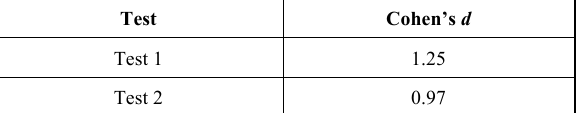
TABLE II. A CHIEVEMENT T ESTS : E FFECT S